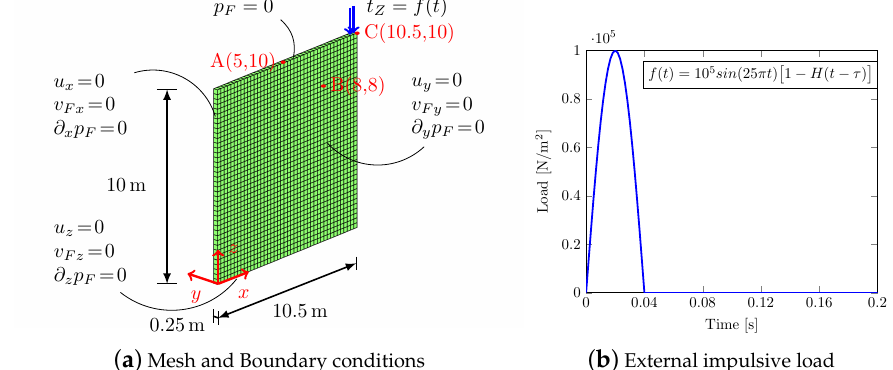
Figure 3. Solutions for Benchmark (1).